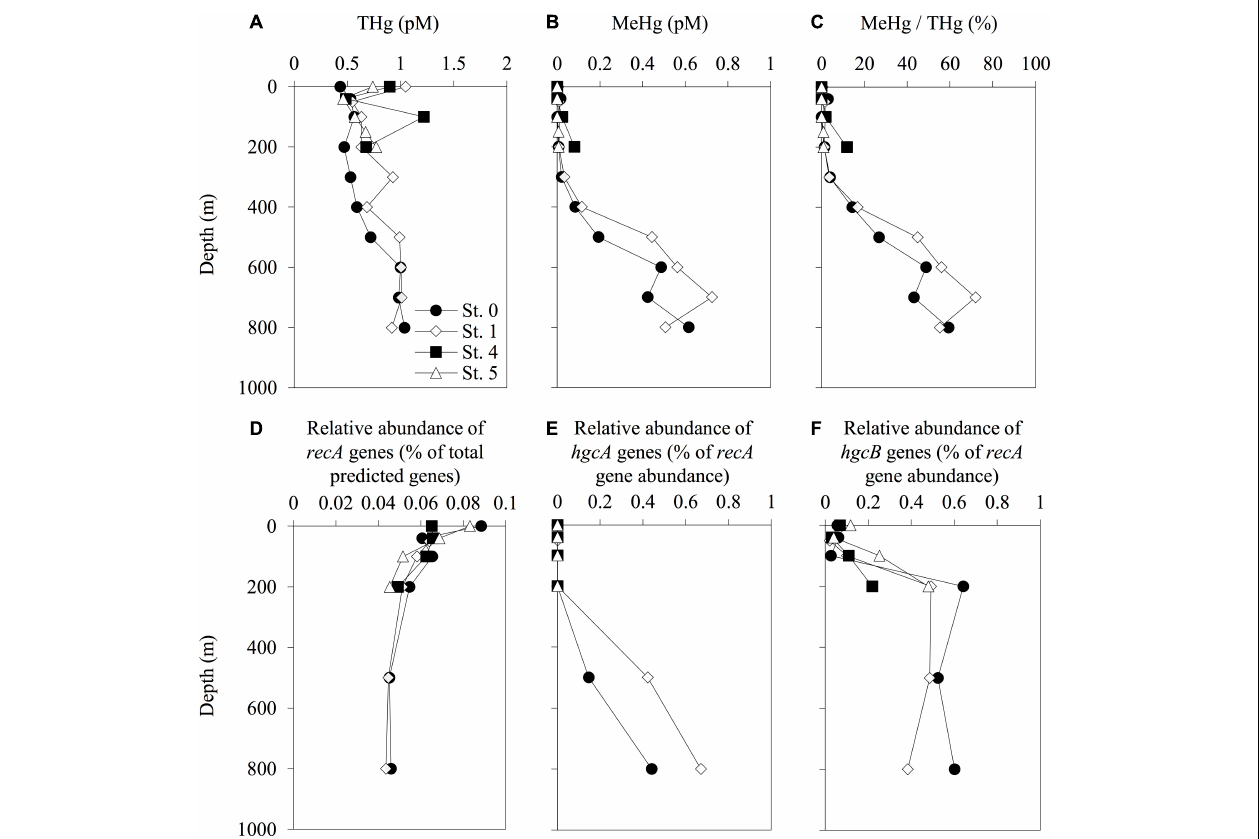
FIGURE 3 | Depth profiles of total mercury (THg) (A) , methylmercury (MeHg) (B) , proportion of THg as MeHg (C) , relative abundance of recA genes among the total predicted genes (D) , and abundance of hgcA (E) and hgcB (F) sequences normalized to recA gene abundance in each sampling station. The abundance of recA and hgcAB genes was determined using the HMMER search on the paired-end reads from the metagenomic sequencing data. Reference libraries were constructed using PFam00154 for recA , and confirmed and predicted hgcAB sequences have been described in Supplementary Tables S2 , S3 . The profiles do not extend to the bottom